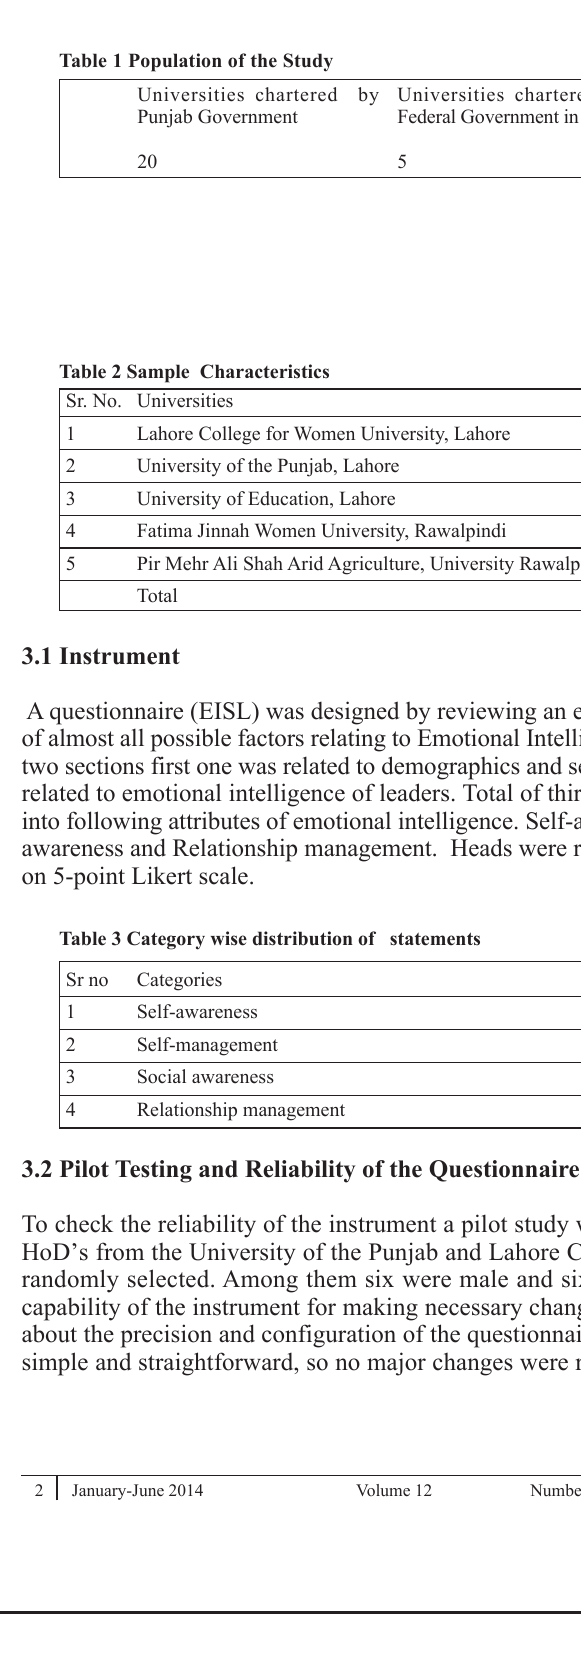
Table 1 Population of the